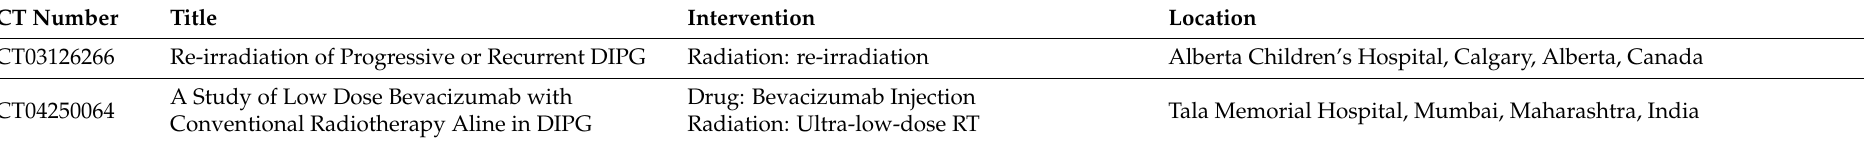
Table 1. Active clinical trials for children with diffuse intrinsic pontine glioma involving radiation therapy as found on www.Clinicaltrials.gov as of 12 January